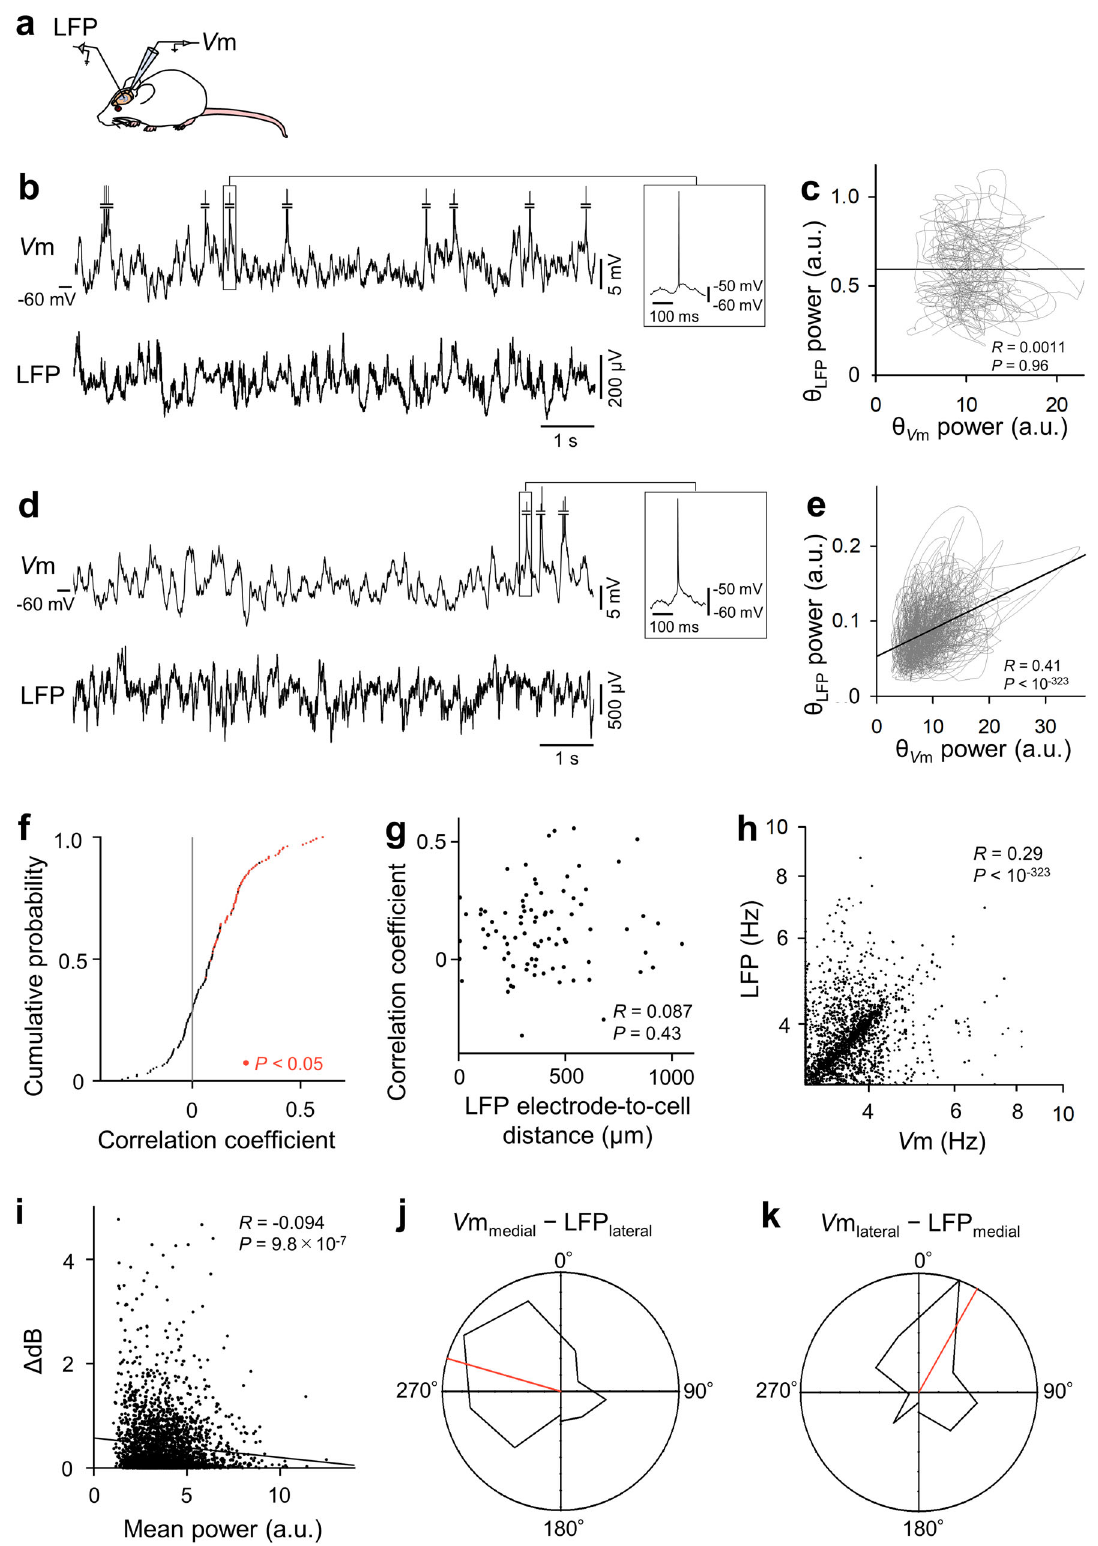
Fig. 7c, f), whereas the remaining 45 cell pairs did not (Supple- mentary Fig. 7e, f). Compared with the LFP-cell pair results in Fig. 3e, the proportion of signi fi cantly correlated cell pairs was high, which might re fl ect the different LFP states in separate datasets. However, the proportion of cell pairs with positive correlations did not change signi fi cantly from the